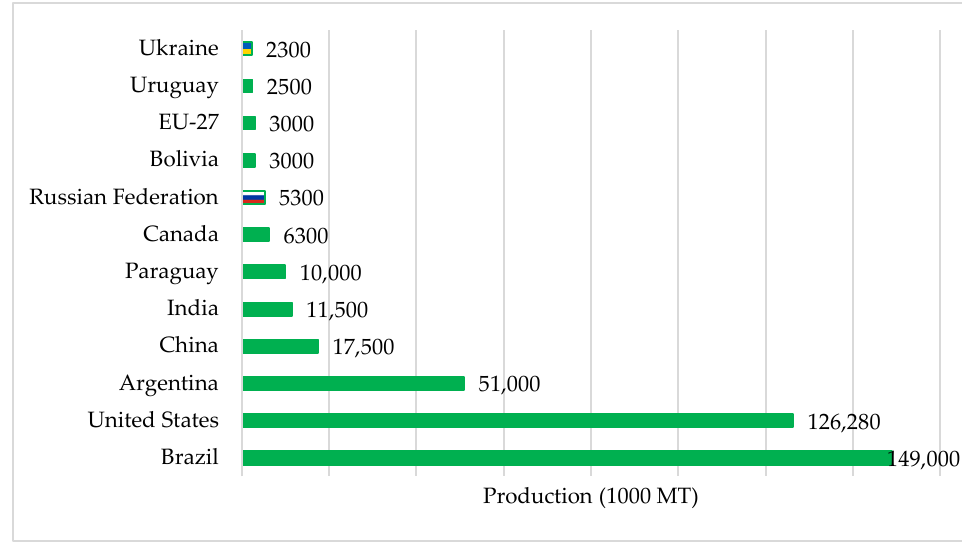
Figure 2. Estimated soybean production in 2022. Source: [25].